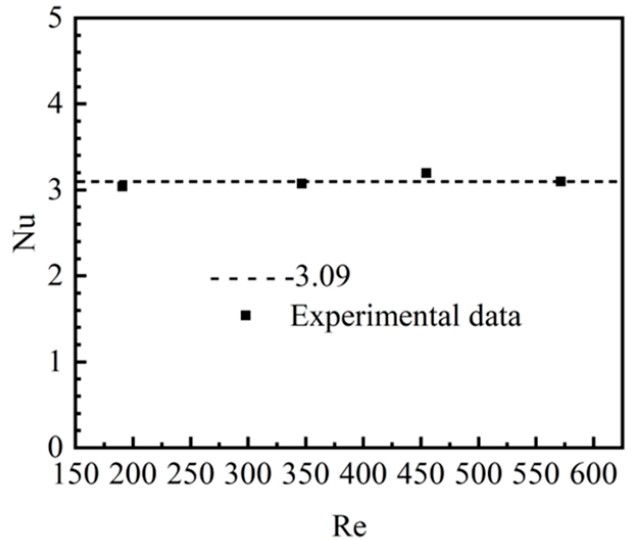
Figure 4. Nusselt number of fully developed section at different Reynolds numbers.